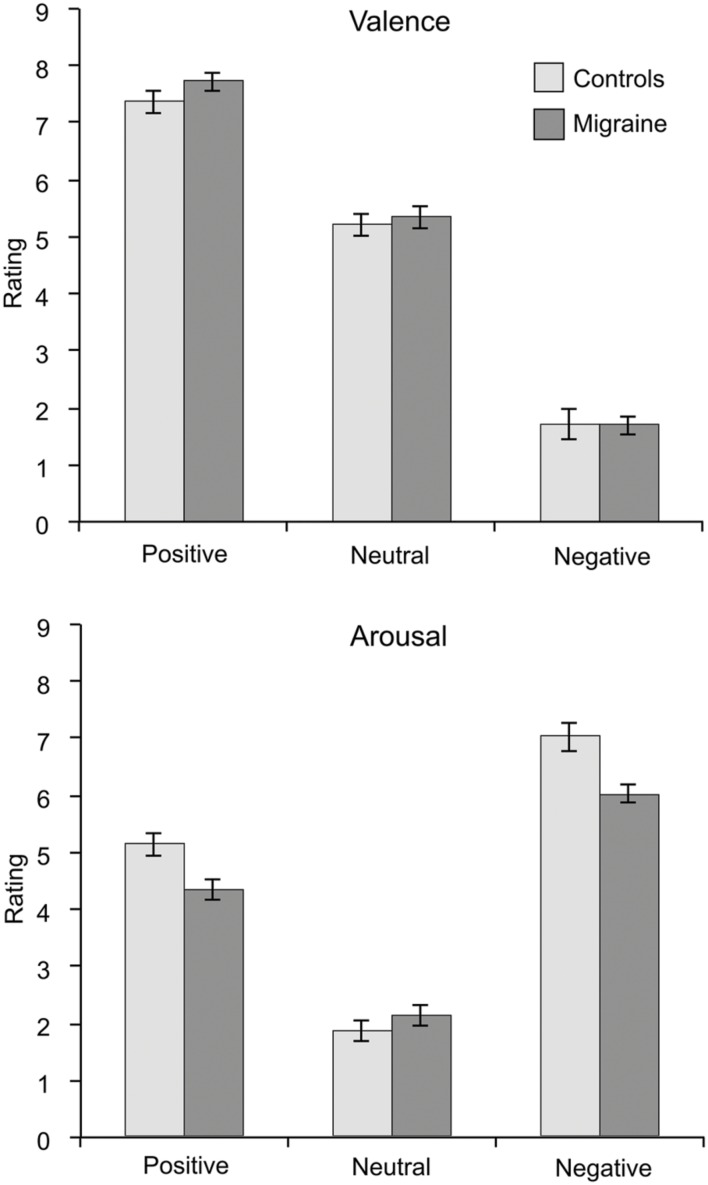
Mean ratings of valence (upper graph) and arousal (lower graph) for the emotional visual stimuli separated for the migraine and the control groups. Error bars represent the standard error of the mean. No significant differences were found in any ratings between migraineurs and controls.